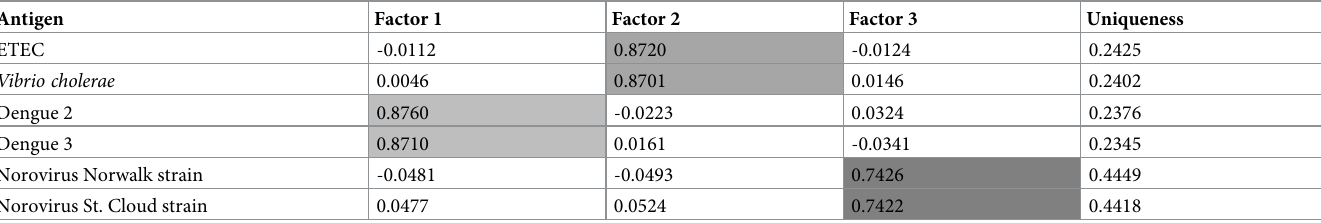
Table 2. Rotated factor loadings and unique